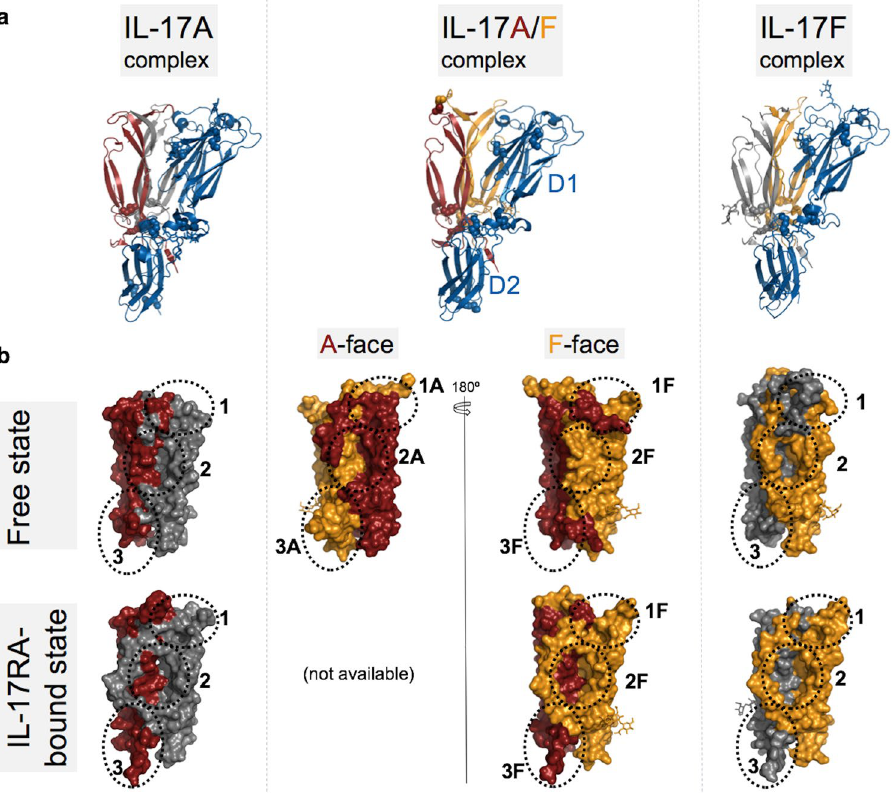
Figure 3. Structural comparison of IL-17RA-cytokine complexes. ( a ) Overall structure of the IL-17A/F complex with IL-17RA (center) compared to the IL-17A (left; 4hsa.pdb) and IL-17F (right; 3jvf.pdb) complexes. The IL-17RA is shown as a blue ribbon, while IL-17A and IL-17F subunits are shown as a carmine or orange ribbon, respectively. The second IL-17 subunit of the homodimeric cytokines is in grey. Disulfide bonds are highlighted as spheres and N-linked glycans are depicted in stick representation. ( b ) Surface representations of IL-17A (left; carmine/grey; 4hr9.pdb), IL-17F (right; orange/grey; 1jpy.pdb) and IL-17A/F (center; carmine/ orange) in the free (top row) and IL-17RA-bound states (lower row). For clarity, IL-17RA is omitted from the receptor-bound states. Sites 1–3 are indicated by dotted lines. The two faces of the IL-17A/F heterodimer in the free state are shown (top row, center). The structure of the IL-17A/F complex with IL-17RA bound to the A-face is not known. Note the occlusion of Sites 1–3 on the “F-face” of free